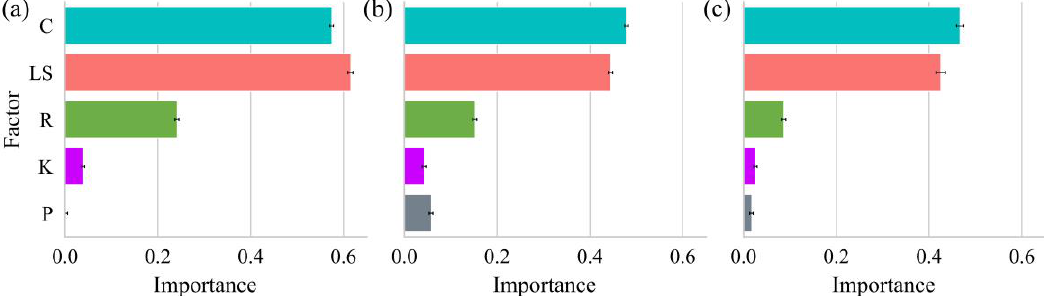
Figure 8. The importance of different factors in three regions. ( a ) Sichuan; ( b ) Guizhou; ( c ) Chongqing. The landforms of Sichuan vary significantly from east to west, with a complex topog- raphy and great height difference. The eastern part of Sichuan is one of the largest